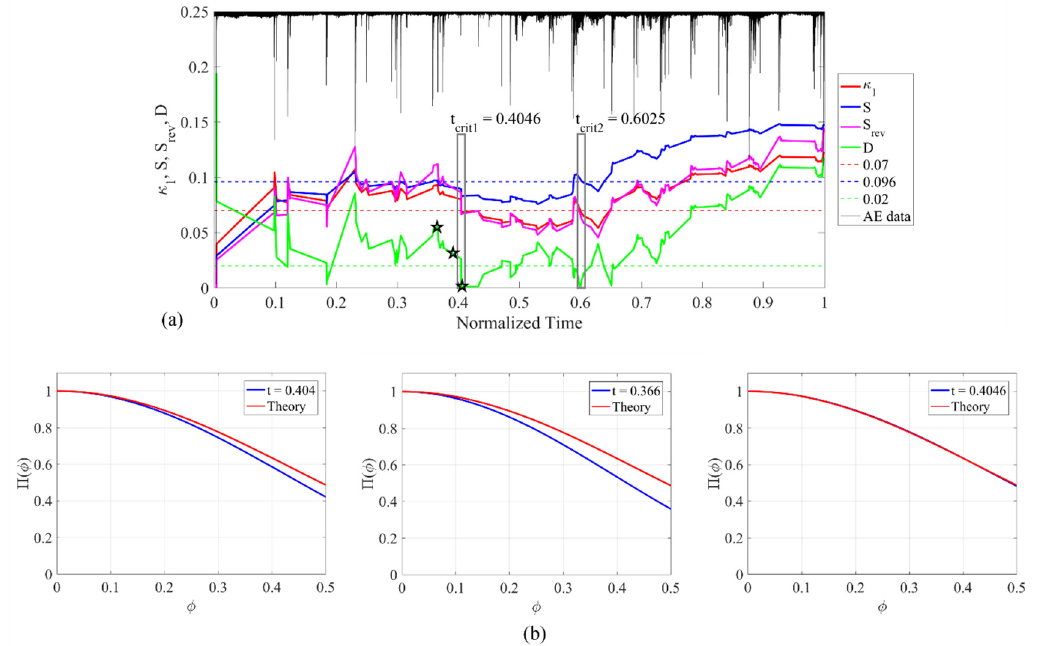
Figure 17. ( a ) Results from the natural time analysis of the AE events during the loading test for the spaghetti model bridge, according to the same format described for Figure 7d. ( b ) Evolution of Π ( φ ) during the same test.